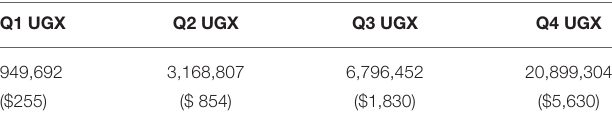
TABLE 2 | Average household disposable income by quartile, BS.